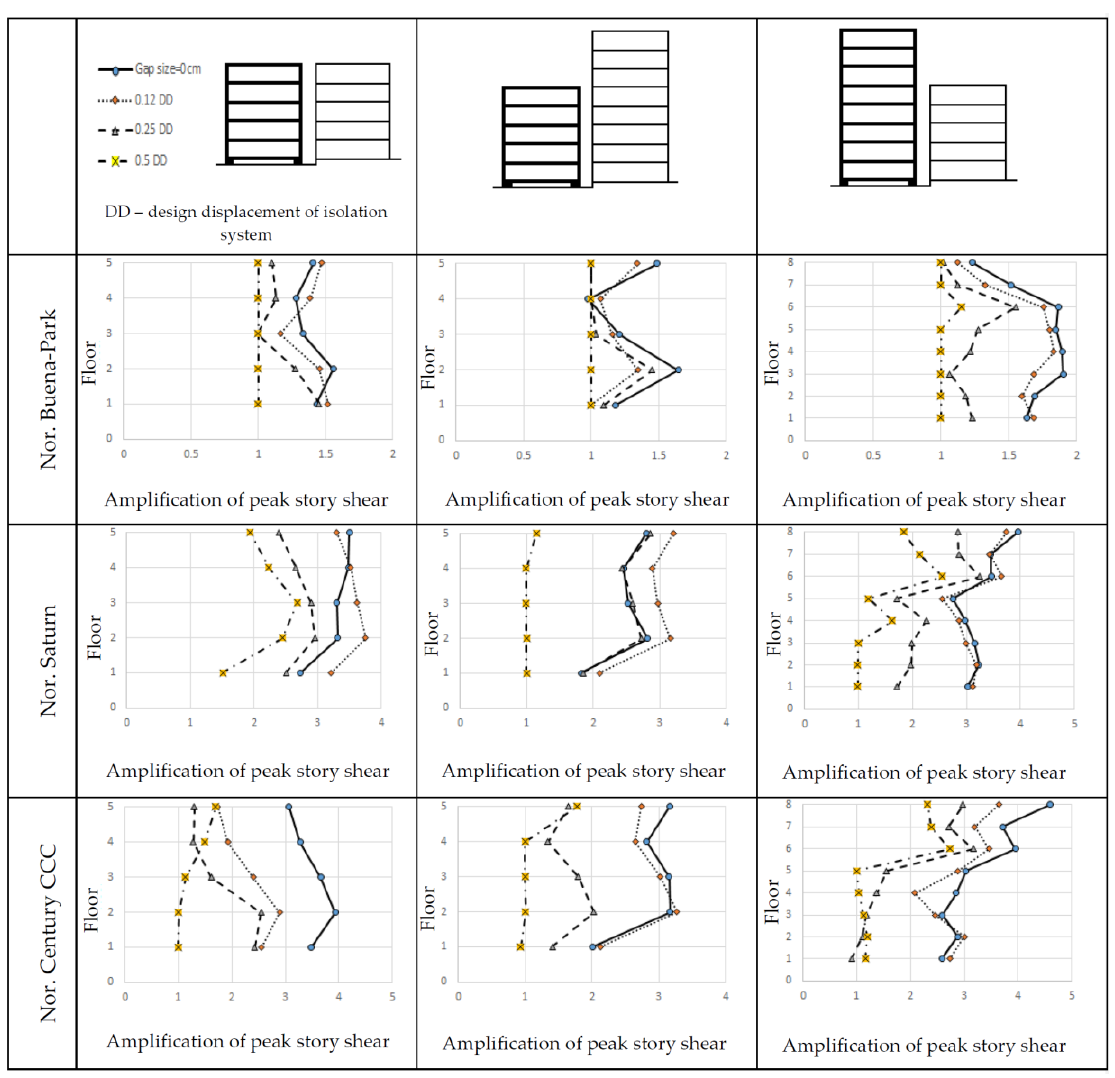
Figure 9. Story shear amplification factors due to pounding for different gap sizes and various stories of the base-isolated building during the Northridge earthquake (stations: Buena-Park, Saturn Street School, and Century CCC).